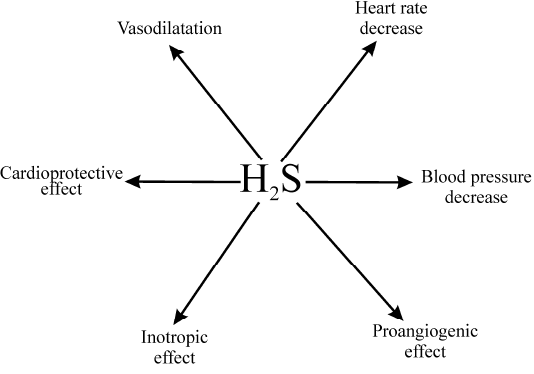
Figure 1. Major cardiovascular effects of hydrogen sulfide donors (H 2 S, ref.: [11,25,26,89–93,95,97]).